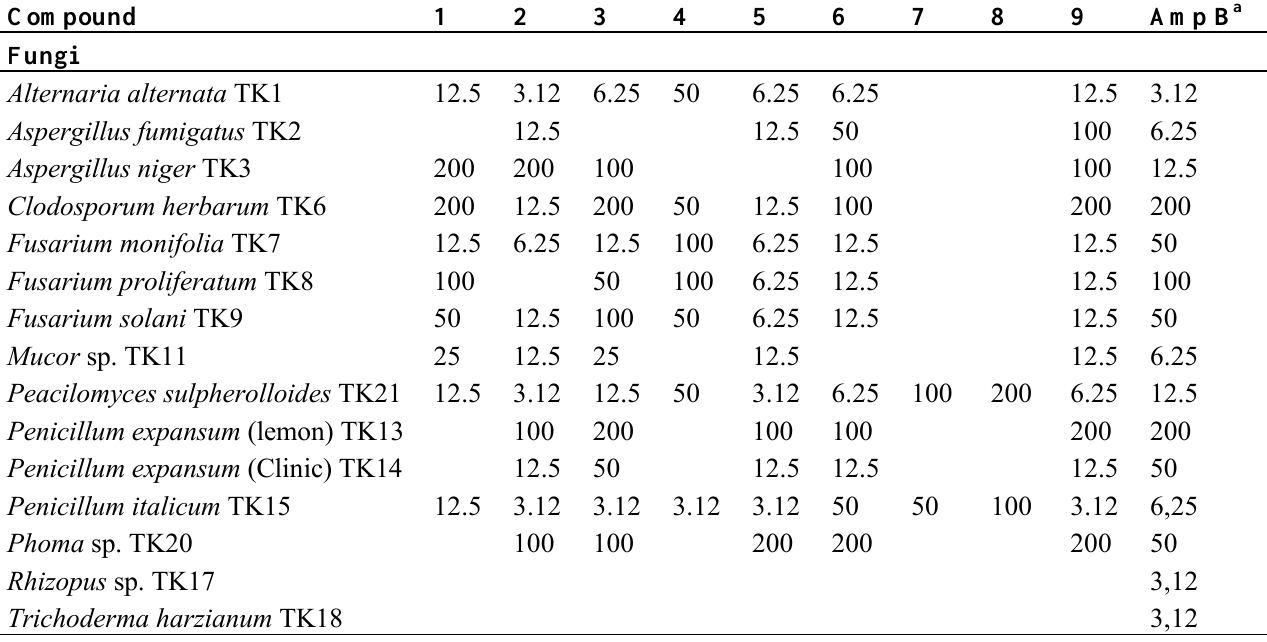
Table 4. Minimal Inhibition Concentration ( MIC) values of synthesized compounds against fungi isolates tested in agar dilution assay ( µ